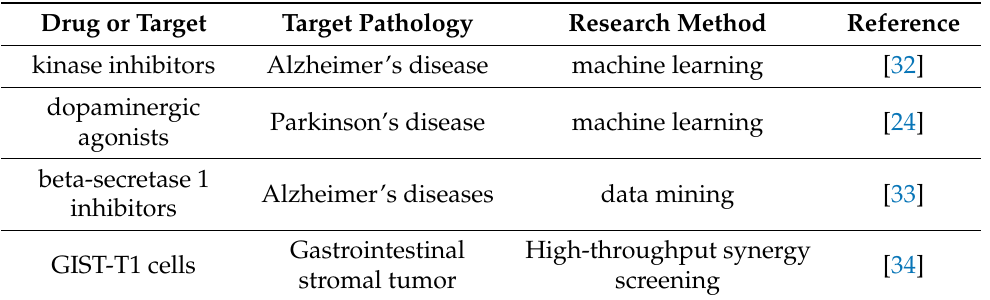
Table 2. Examples of drug or drug targets that have been identified using computational